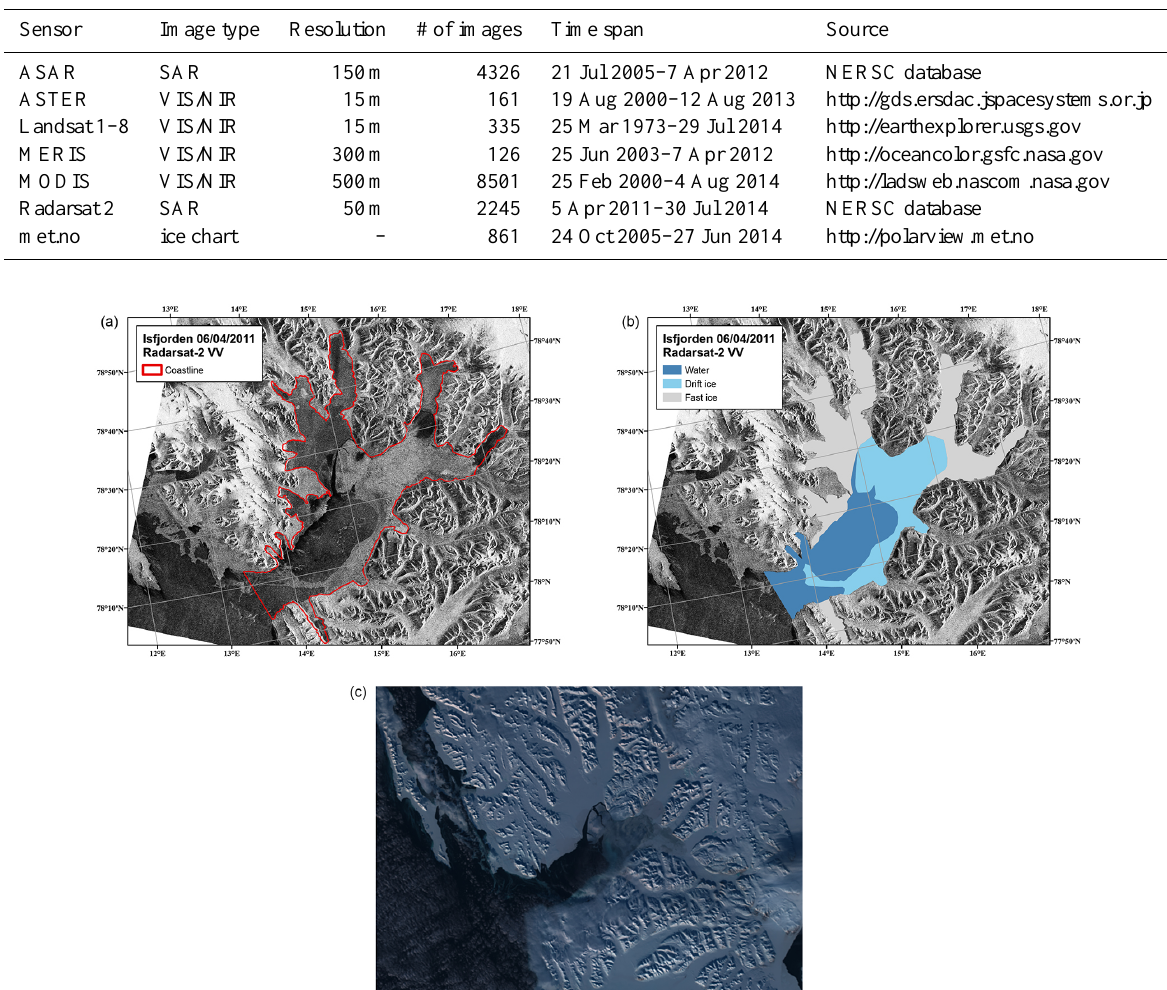
Figure 2. Radarsat-2 (a,b) and MERIS (c) images of Isfjorden taken on 6 April 2011. Radarsat-2 images are shown in ArcGIS with adjusted symbology (a) before and (b) after analysis by a sea ice